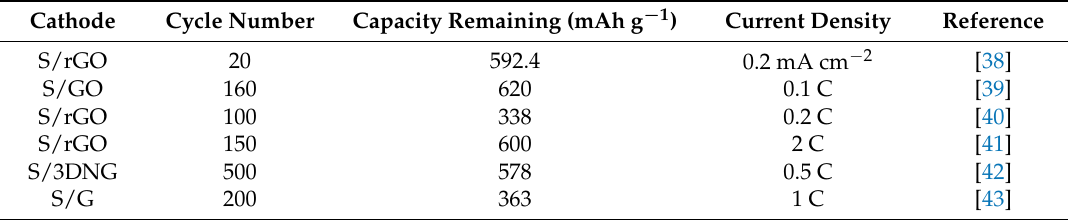
Table 1. Literature comparison of the electrochemical performances of composite cathode materials for lithium sulfur batteries.